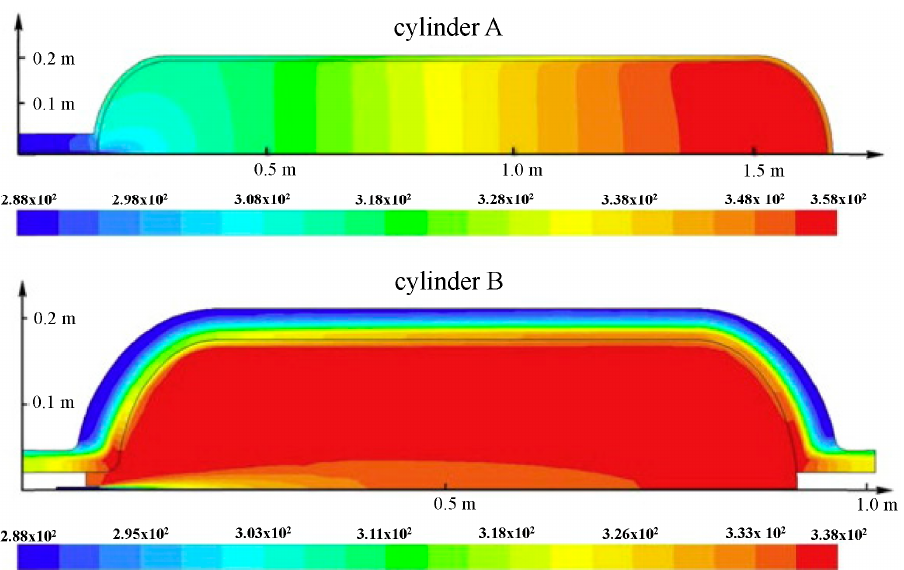
Figure 11. Hydrogen temperature distribution within the cylinder at the end of refueling [172].